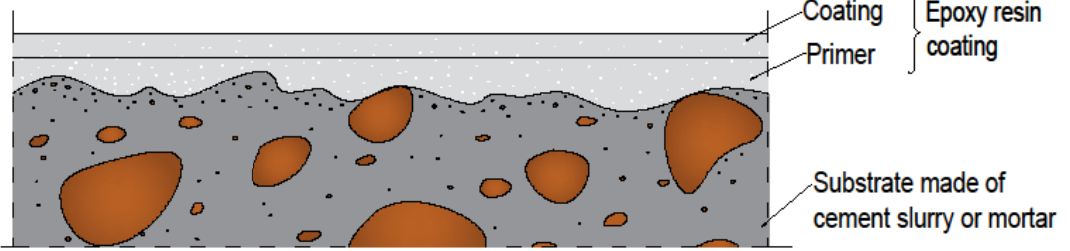
Figure 1. Cross-section of a typical industrial floor made of epoxy resin coating.